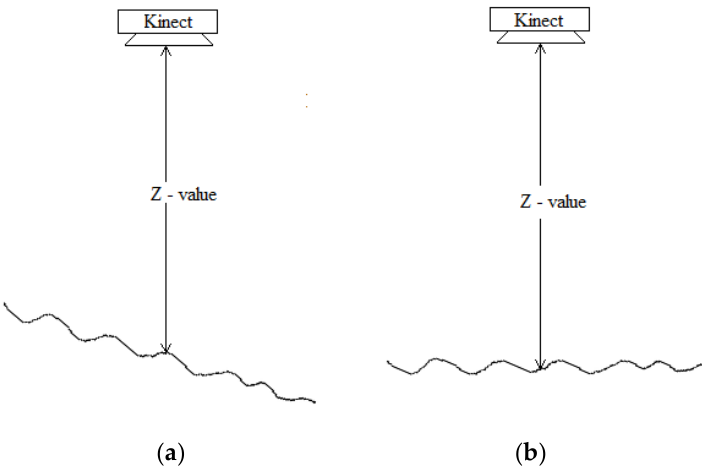
Figure 4. Kinect Z-values, ( a ) with bed surface slope, ( b ) leveling bed surface.